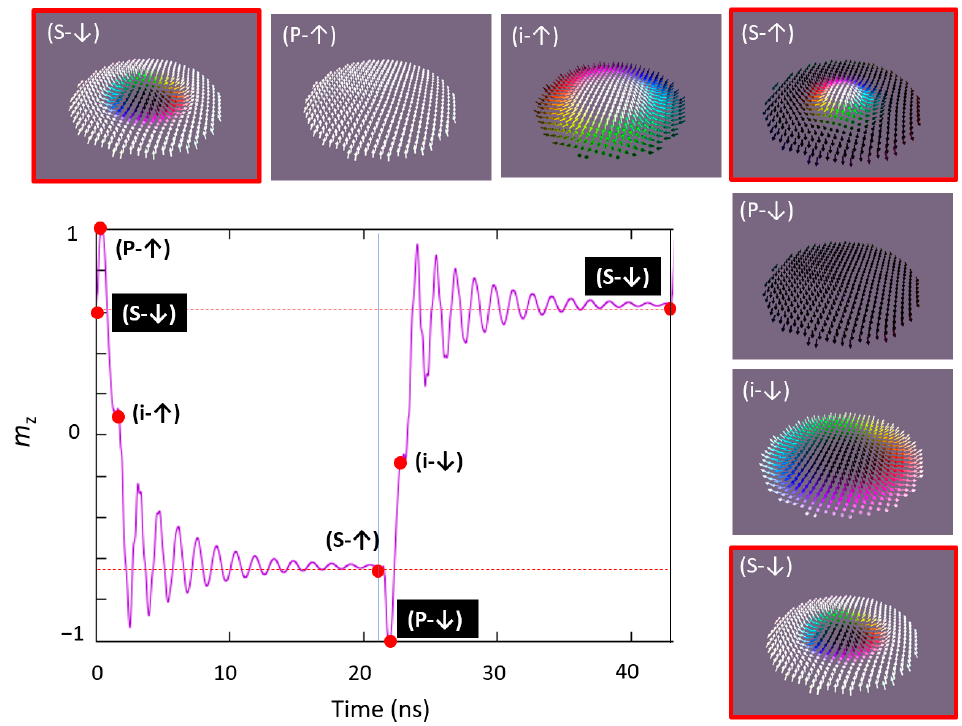
Figure 26. Magnetization dynamics of the m z component during two successive cycles of skyrmionic core reversal by electric field. Corresponding micromagnetic configurations of some representative magnetic states: skyrmion with up(down) core orientation [S- ↑ ( ↓ )], saturated perpendicular up(down) [P- ↑ ( ↓ )], intermediate up(down) states [i- ↑ ( ↓ )], are represented.